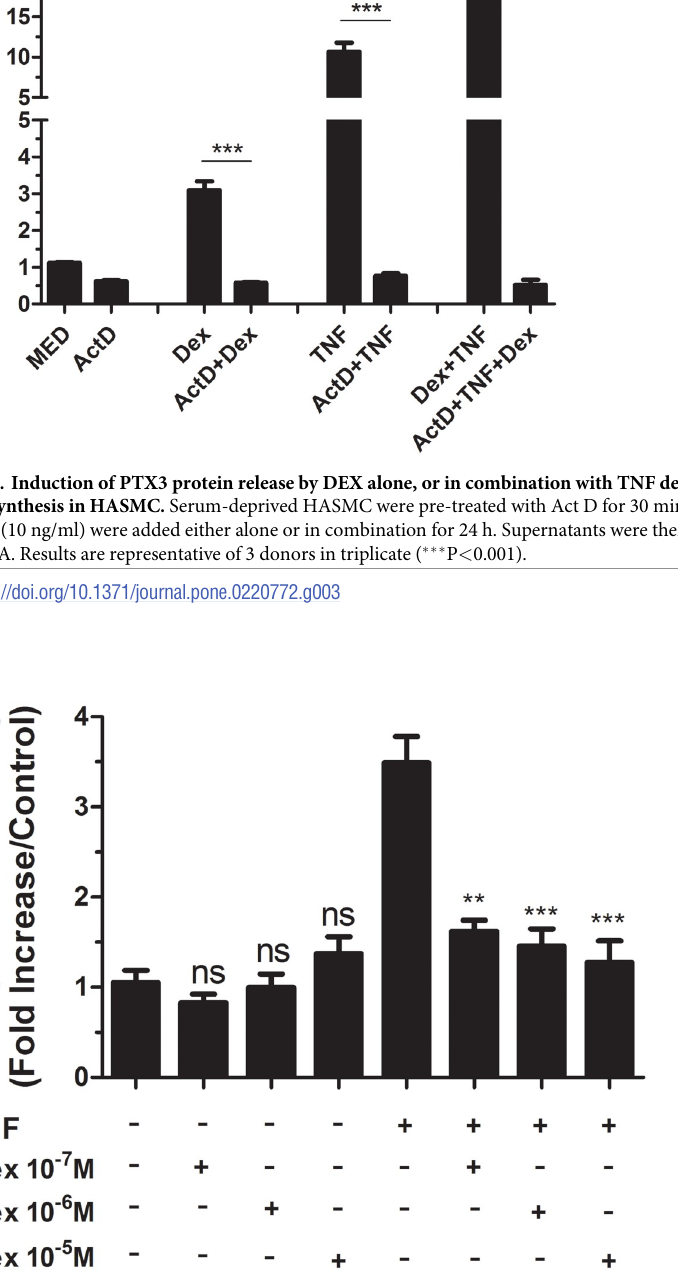
Fig 4. Transcriptional regulation of the PTX3 promoter by DEX. HASMC were transiently transfected with the PTX3 promoter-luciferase construct and stimulated with different concentrations of DEX either alone (10 − 7 M, 10 − 6 M, and 10 − 5 M), or with TNF (10ng/ml) for 16 h. Values are presented as mean fold increase of luciferase activity normalized to the mock Renilla luciferase activity from 4 different donors. �� P < 0.01, ��� P < 0.001 compared with TNF- stimulation group; ns, not significant compared with the medium